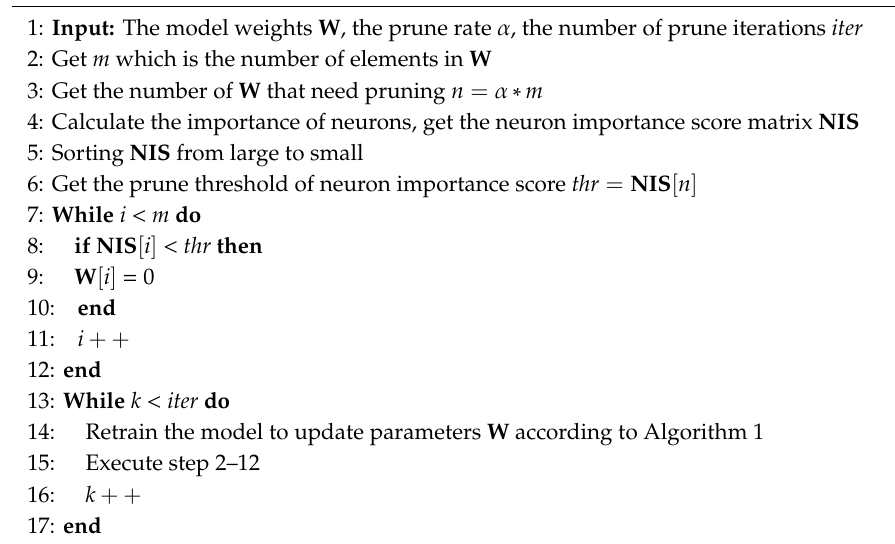
Algorithm 2: Pruning